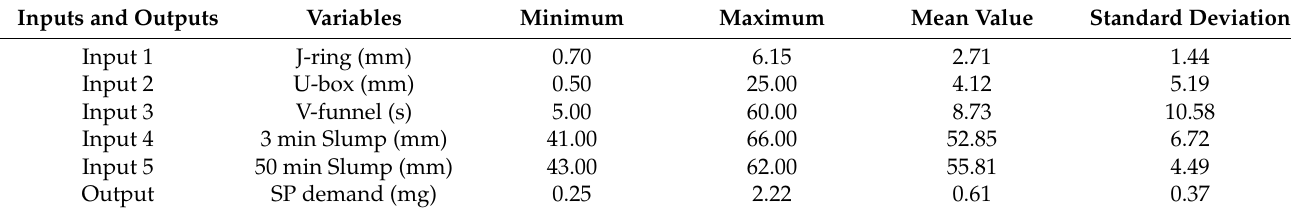
Table 3. Details of the input and output variables.